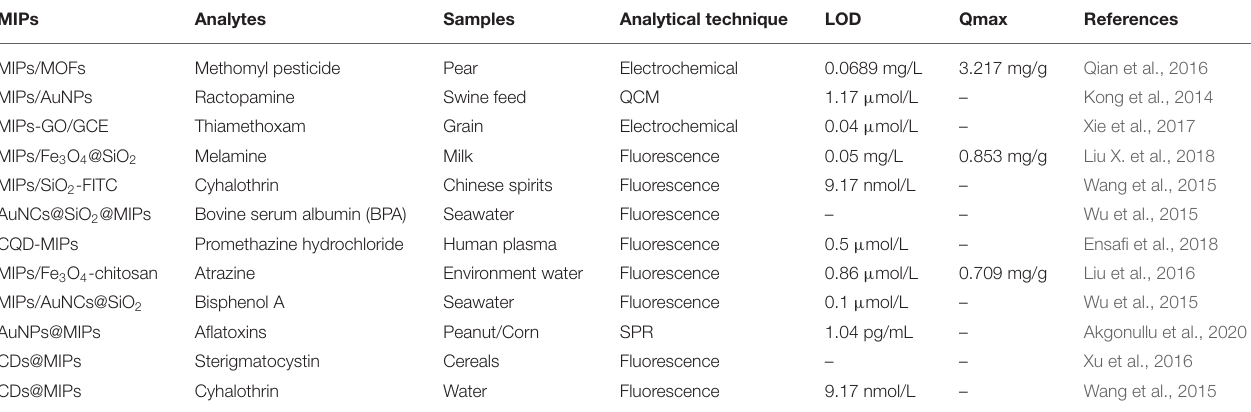
TABLE 2 | Comparison of different detection methods for chemical pollutants based on